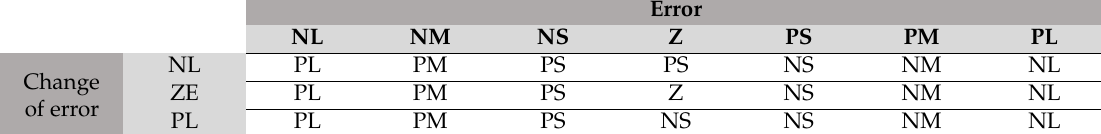
Table 1. Fuzzy rules used for the Horizontal and Vertical controllers.